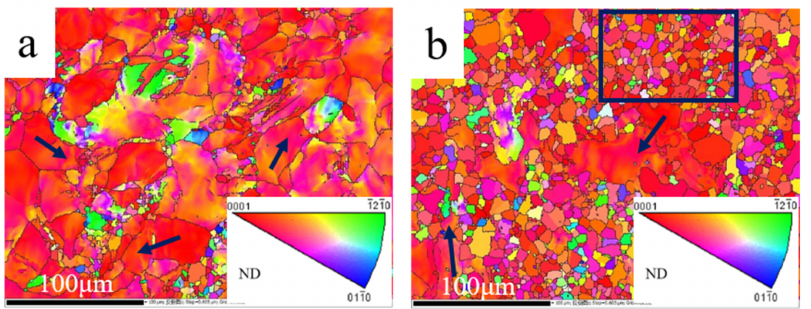
Figure 6. Grain orientation map of cold-rolled deformed TA2 alloy sample after nitriding treatment. ( a ) 40% and ( b )